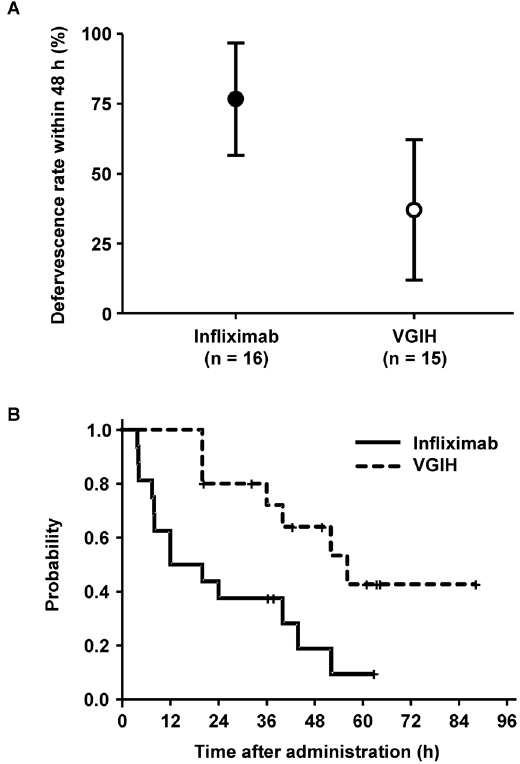
Figure 2. Defervescent effect. ( A ) Defervescence rate (adjusted least squares mean, 95% CI) within 48 h after study drug administration. ( B ) Kaplan–Meier plot of febrile duration. CI, confidence interval; VGIH, polyethylene glycol-treated human